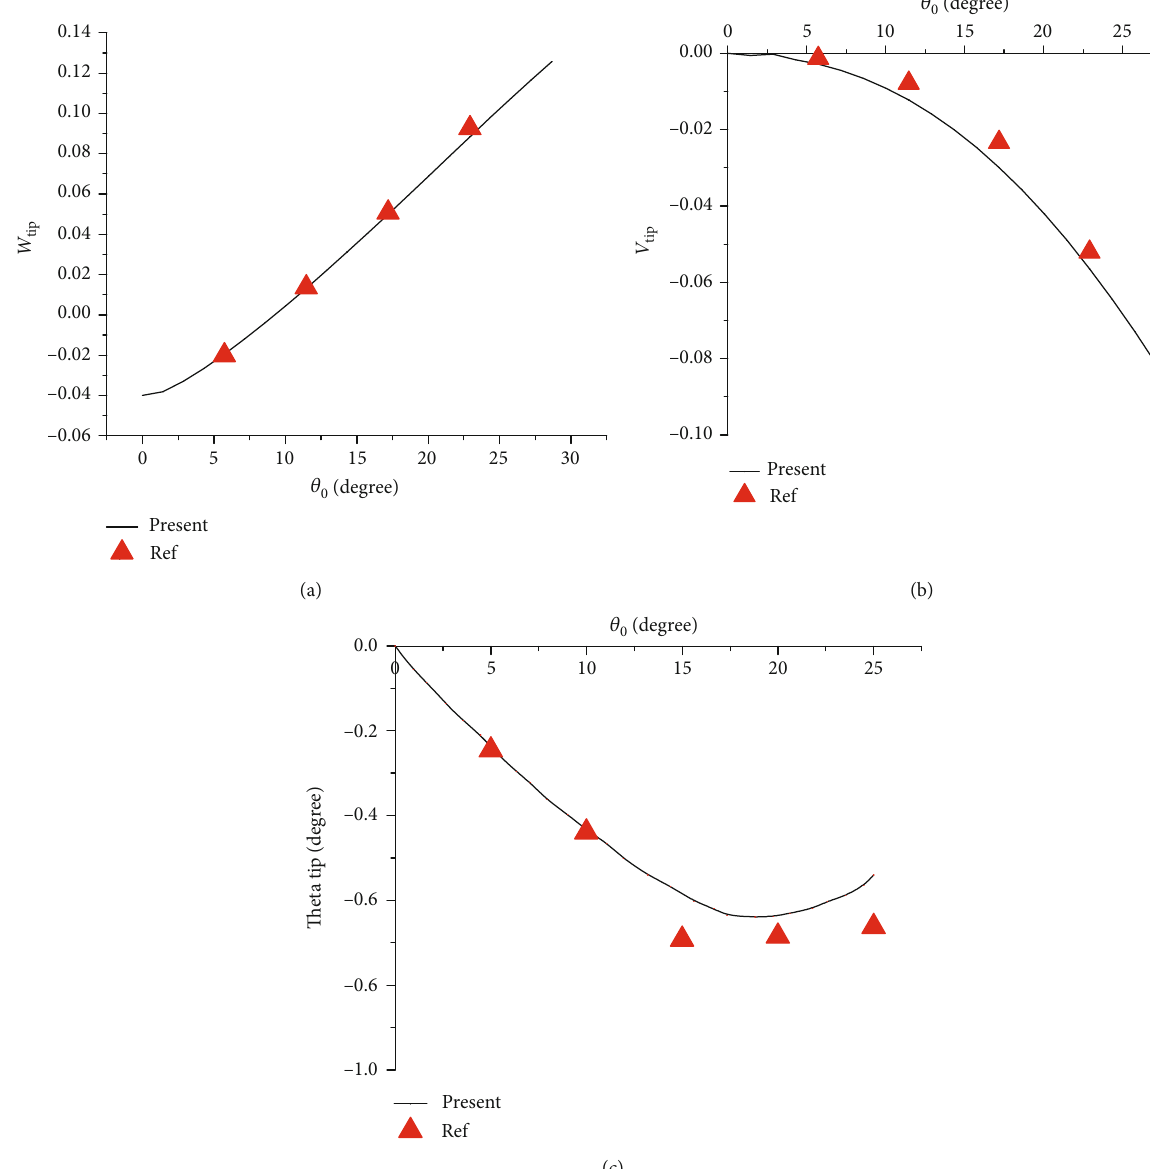
= 1 : 15 , ω = 1 : 5 , and ω = 5 : 0 w v ϕ